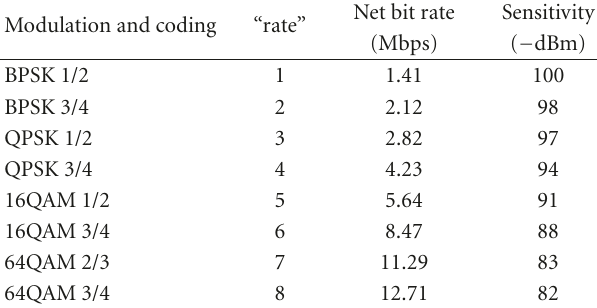
Table 2: Alvarion’s BreezeMAX adaptive modulation